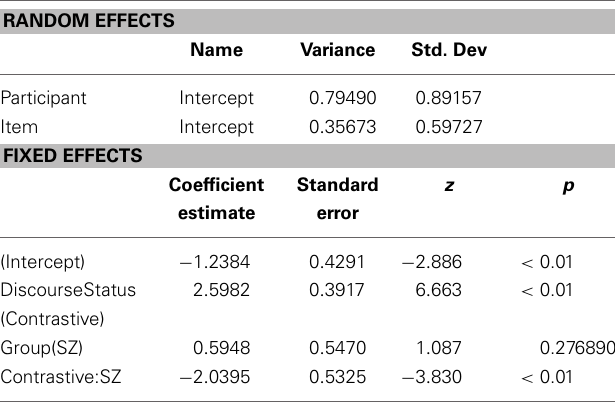
Table 3 | Results of the linear mixed models fitted on the logarithms of duration values and on the logarithms of f0